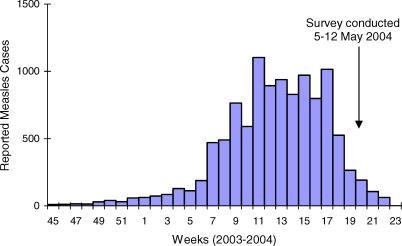
Reported Measles Cases in Niamey, Niger (2003–2004) (10,880 Patients)